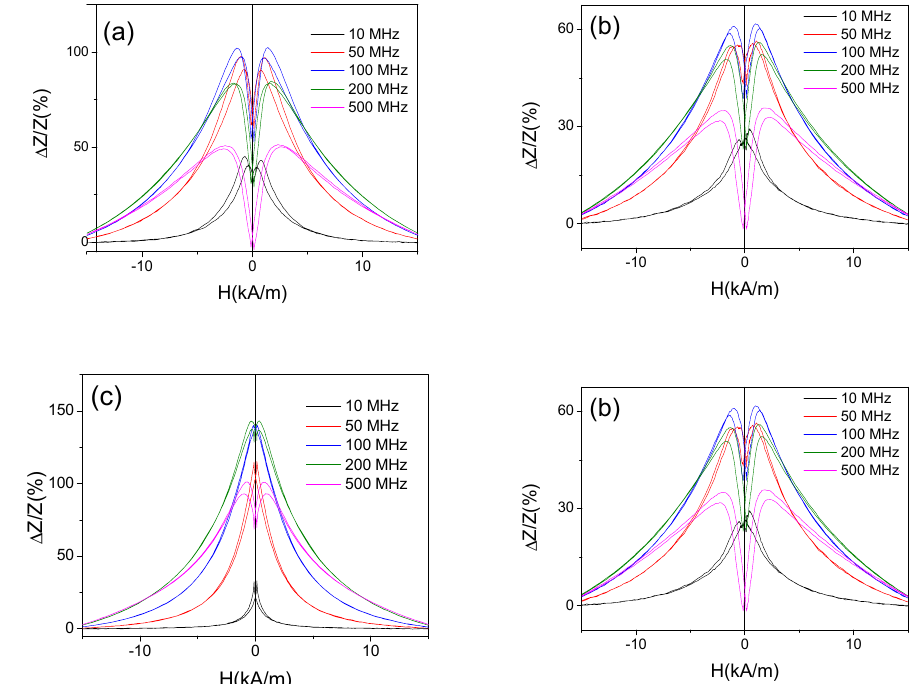
Figure 7. ∆ Z / Z ( H ) dependencies of as-prepared ( a ) and annealed at 200 ◦ C ( b ), 300 ◦ C ( c ) and 325 ◦ C Figure 7. Δ Z/Z ( H ) dependencies of as-prepared ( a ) and annealed at 200 °C ( b ), 300 °C ( c ) and 325 °C ( d ) Fe 3.6 Co 69.2 Ni 1 B 12.5 Si 11 Mo 1.5 C 1.2 microwires.